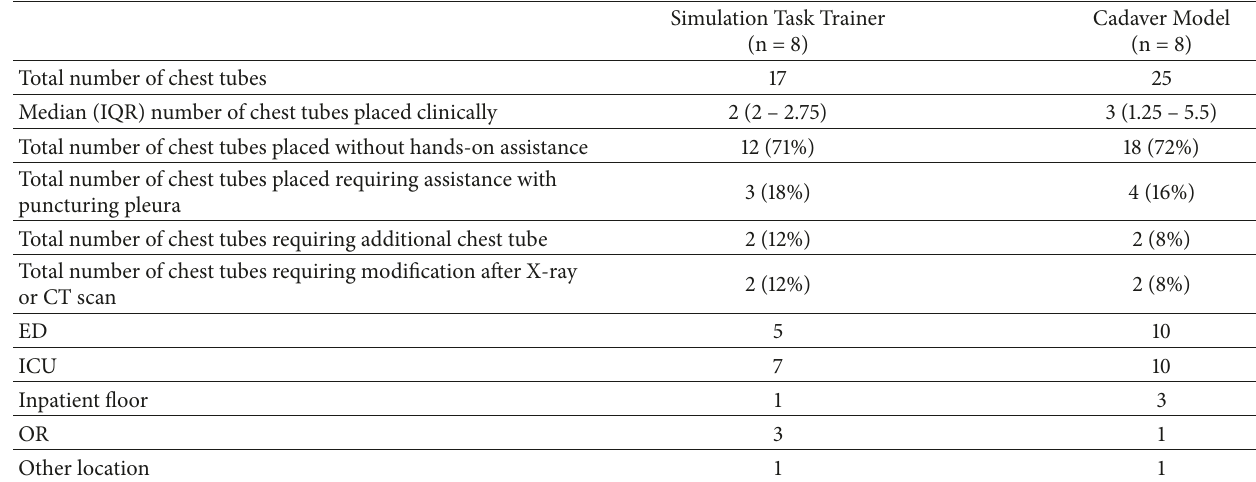
Table 3: Clinical